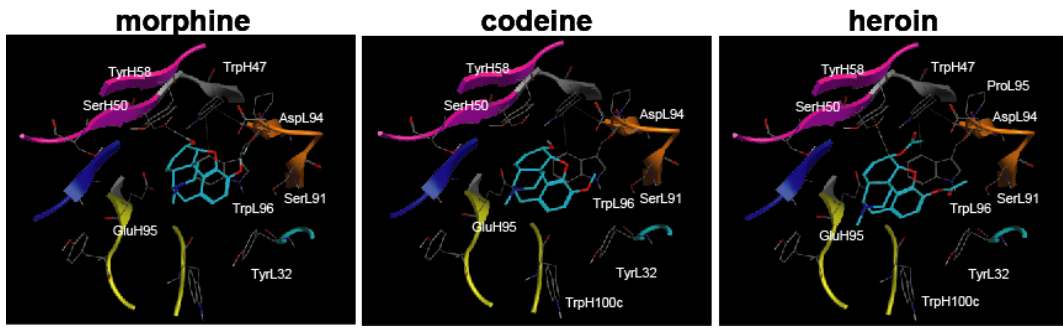
Figure 9. Binding models of morphine-related compounds to M86 scFv indicated by a top view of the M86 binding pocket. The structure of M86 scFv was simulated as described in Figure 7. M86 is shown as a ribbon structure (CDRH1, cyan; CDRH2, magenta; CDRH3, yellow; CDRL1, blue; CDRL2, red; CDRL3, orange), and narcotics are shown as blue stick structures for morphine (left), codeine (middle), and heroin (right). The amino acid residues around the ligand interaction site are shown as a stick model using the numbering of Kabat and Wu [24]. The hydrogen bond interaction is denoted by a dotted line. Left panel: M86 binding to morphine; Middle panel: M86 binding to codeine; Right panel: M86 binding to